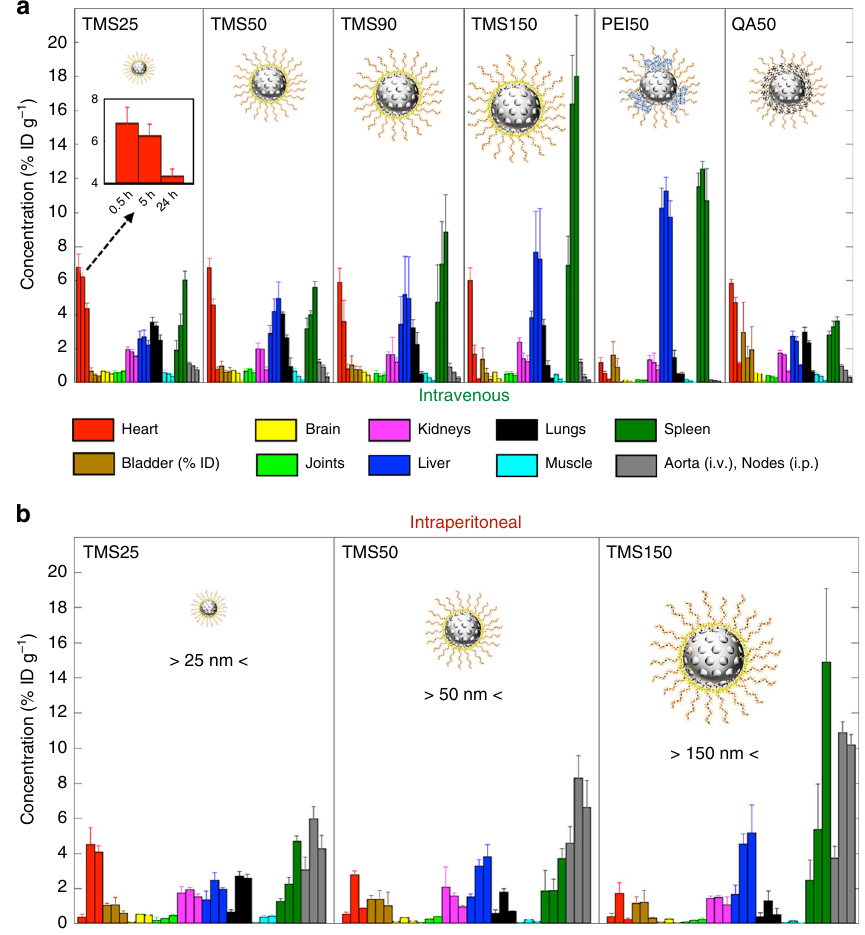
Fig. 3 Whole-body quantitative biodistribution of MSNs. Bar plots of mean concentration – time data for various ROIs following a , i.v. and b , i.p. injection of MSNs are shown. For each MSN-type, concentration (%ID g − 1 ) of MSNs in ten ROIs is shown at 30 min, 5 h (6 h for TMS150 (i.v.)), and 24 h, represented by three adjacent bars of same color (see inset in a ). Data represents mean ± s.d., n = 4 (except TMS50 (i.p.) and TMS25 (i.p.), where n = 3). Note: Data for urinary bladder ROI is presented as activity (%ID) and not as